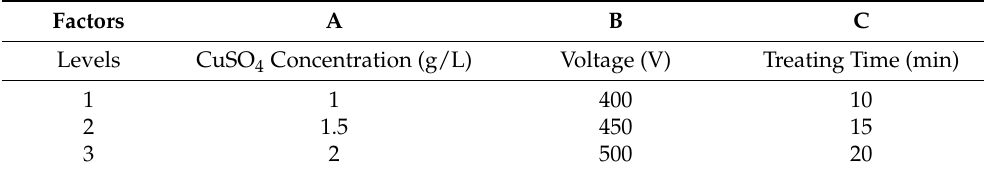
Table 1. Factors and levels of the orthogonal